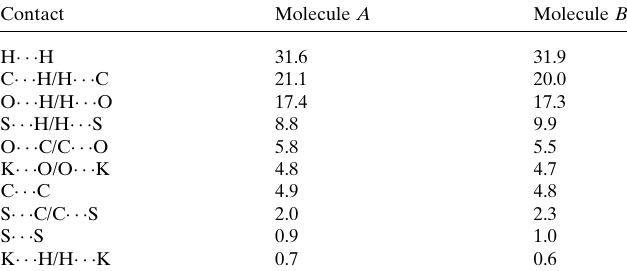
Table 2 Percentage contributions of interatomic contacts to the Hirshfeld surfaces of the two